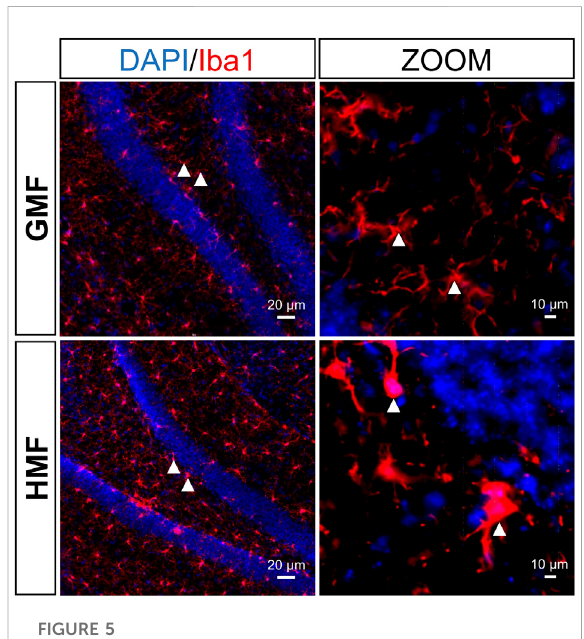
FIGURE 5 The hypomagnetic fi eld (HMF) led to partial activation of microglia in the DG of hippocampus. Representative images of microglia in the hippocampal neurogenic niche under different